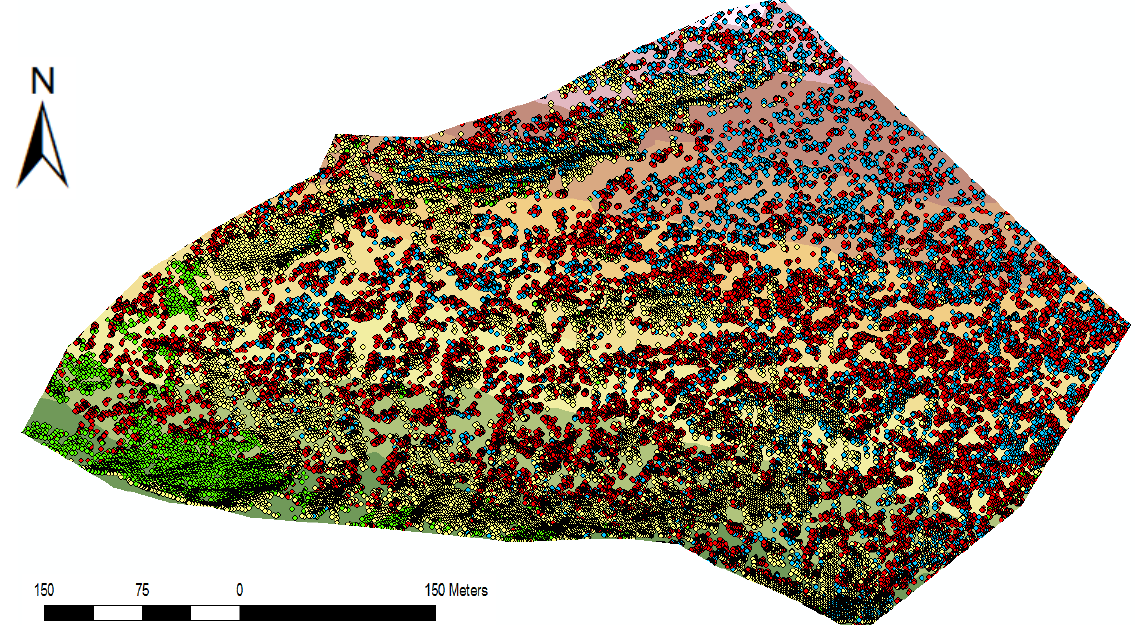
Figure 11. First test area—point classification of the new calculated model (filter angle 50 degrees), compared with the manually filtered terrain model in the form of a colour-separated point cloud.